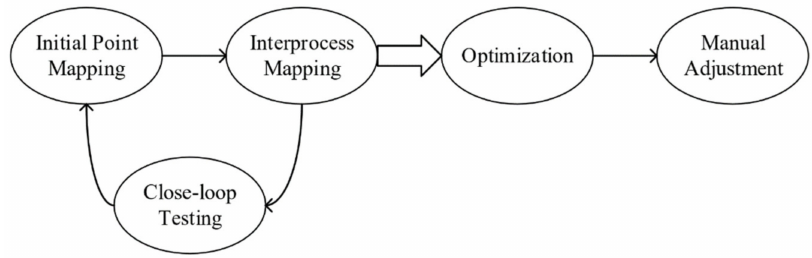
Figure 6. The framework of simultaneous localization and mapping (SLAM).